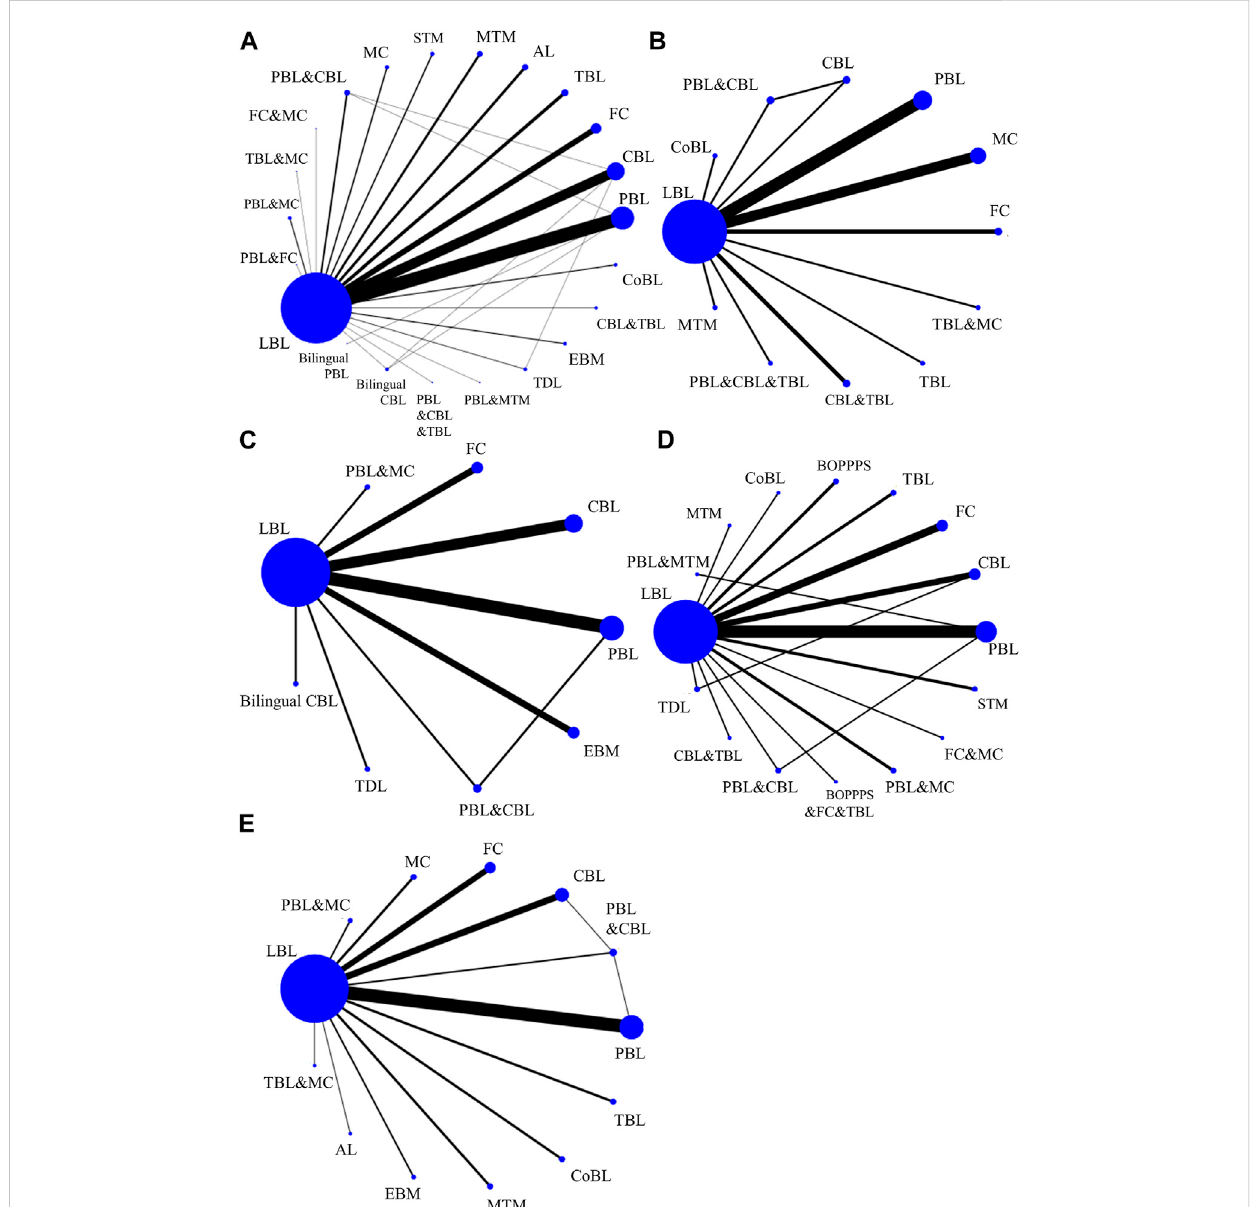
FIGURE 3 Network of teaching strategies in the Bayesian network meta-analysis. (A) The theoretical test score. (B) The experimental test score. (C) The subjective test score. (D) The satisfaction score. (E) The proportion of satisfaction. AL, active learning; BOPPPS, bridge-in, objective, pre-assessment, participatory learning, post-assessment, and summary; CBL, case-based learning; CoBL, computer-based learning; EBM, evidence-based medicine; FC, fl ippedclassrooms;LBL,lecturebasedlearning;MC,microclassrooms;MTM,mixedteachingmode;PBL,problem-basedlearning;STM,scaffolding teaching method; TBL, team-based learning; TDL, task driven